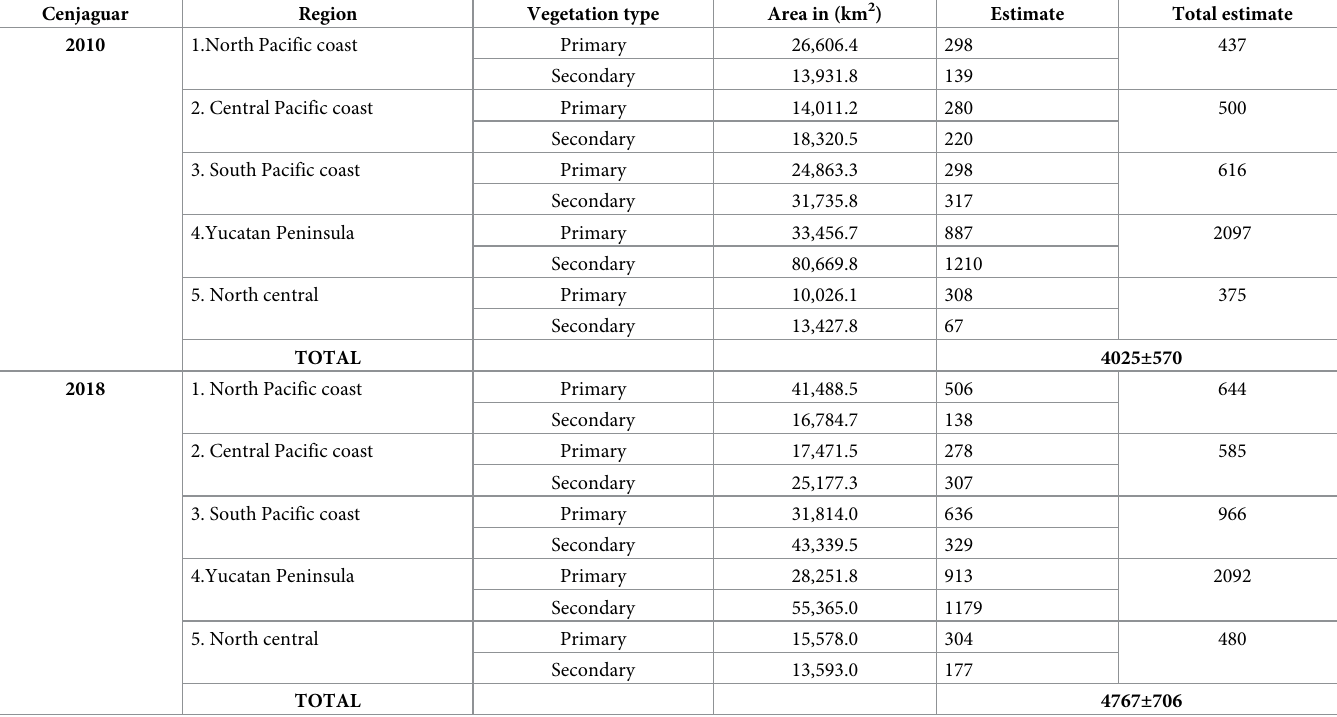
Table 4. Estimates of potential jaguar populations for both censuses relative to vegetation type and available suitable area for each region. Cenjaguar